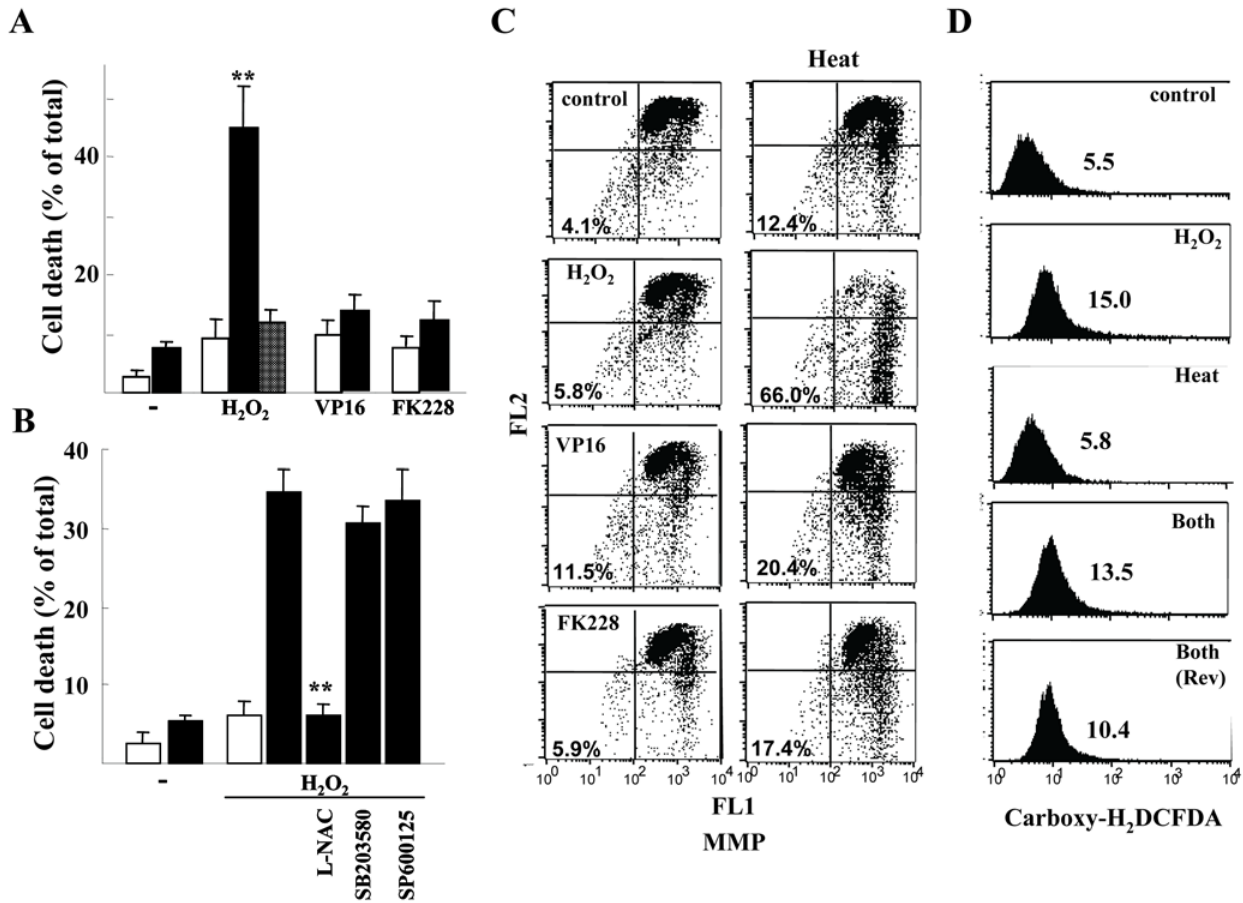
Figure 1. Cell death in H 2 O 2 and/or heat-treated T98G cells. A ) Trypan blue exclusion assay. Cell death 24 h after heat exposure (44 u c for 20 min) (closed bars) with the indicated pretreatments (0.25 mM H 2 O 2 , 25 m g/ml VP16 or 50 nM FK228). Alternatively, cells were exposed to heat and thereafter treated with 0.25 mM H 2 O 2 as reverse treatment (gray bar) or unexposed to heat (open bars). **, P , 0.01 compared with cells treated alone as indicated. B ) Cell death was evaluated 20 h after heat exposure. Cells were pretreated with 5 mM L-NAC, 10mM SB203580 or 10 mM SP600125 for 2 h, thereafter treated with 0.25 mM H 2 O 2 , and unexposed (open) or exposed (closed bars) to 44 u c for 20 min. **, P , 0.01 compared with heat/H 2 O 2 - treated cells. In A and B , error bars indicate the mean 6 S.D. of data from three separate experiments. C ) Disruption of Dy m. Cells were cultured for 20 h after the indicated treatments as described in A ), and then intracellular DePsipher fluorescence was detected. Numbers indicate % of cells showing loss of Dy m. D ) ROS generation. Carboxy-H 2 DCFDA fluorescent signals 2 h after treatment with 0.25 mM H 2 O 2 (H 2 O 2 ), heat exposure (44 u c for 20 min; Heat) or both (Both). Both (Rev) indicates reverse treatment (heat exposure before H 2 O 2 treatment). In representative histograms, numbers indicate mean fluorescence